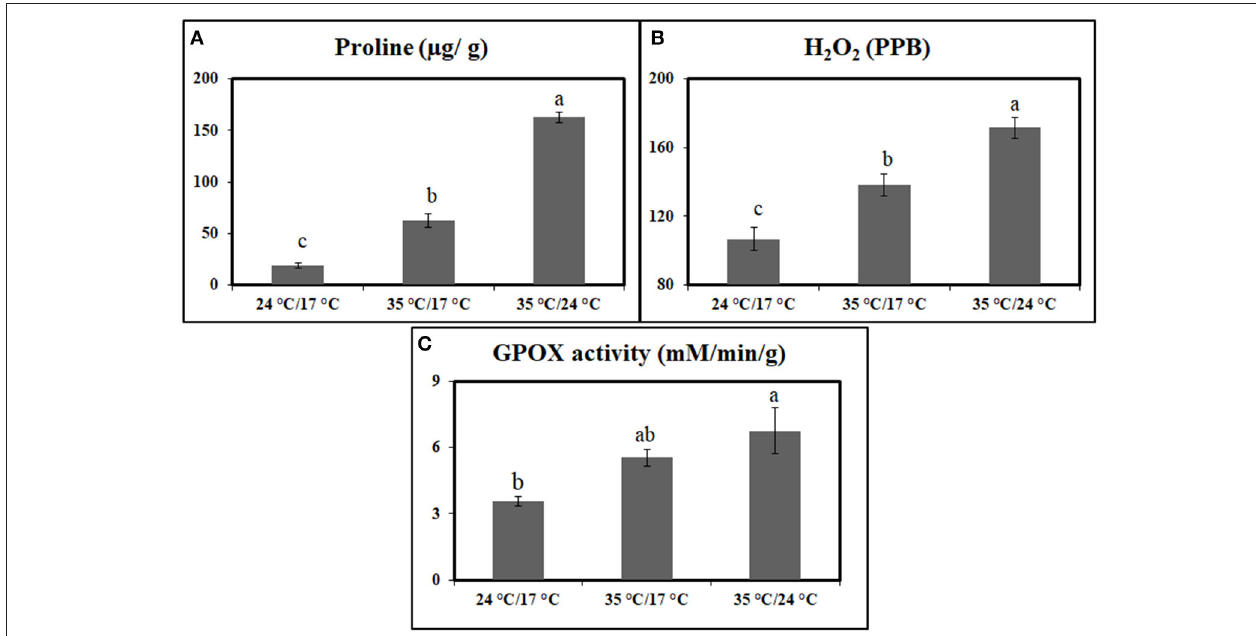
FIGURE 1 | Graph representing the effect of heat stress during the grain-filling period on antioxidants and antioxidant enzymes between control, day heat stress, and day–night combined heat stress. (A) Proline ( µ g/g); (B) H 2 O 2 (ppb). (C) Glutathione peroxidase (mM/min/g). Values were given in Mean ± SE. Variables with the same letter are not significantly different from each other at P ≤